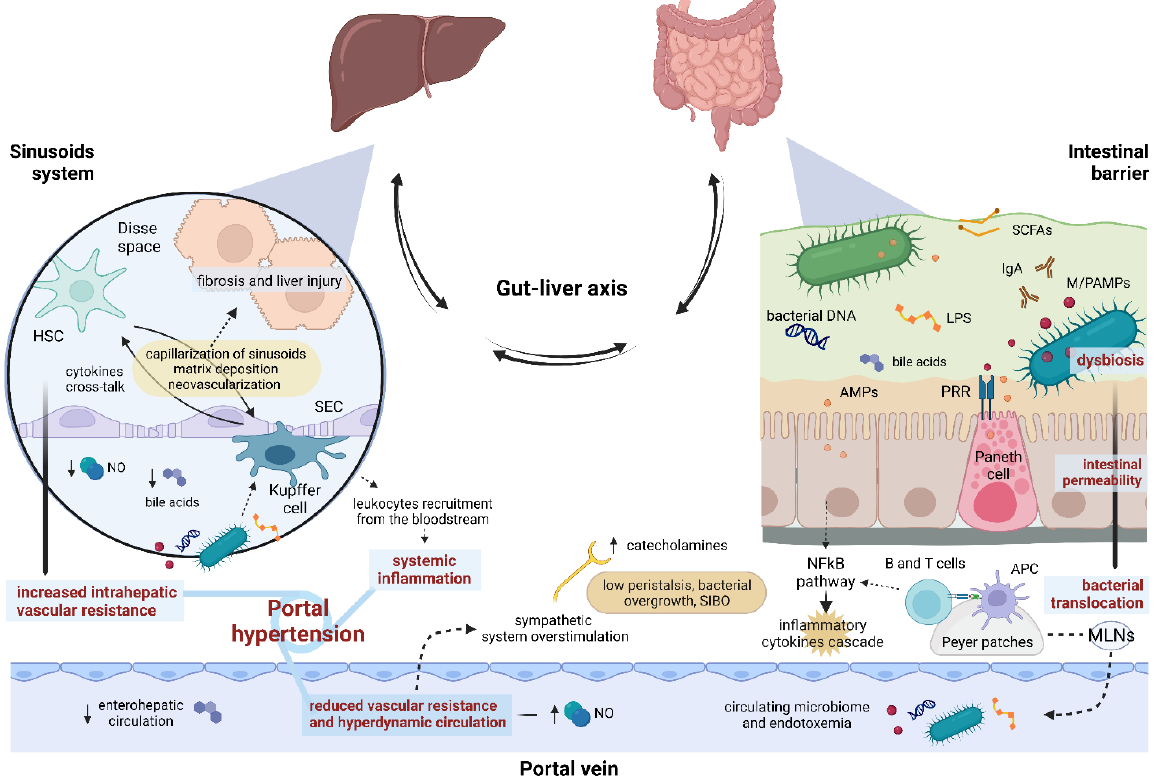
Figure 1. Gut–liver axis and portal hypertension. The intestinal barrier and the hepatic sinusoid system represent the two hinges of the firewall involved in containing bacterial translocation within the gut–liver axis. Impairment of continuous, bi-univocal communication between all these elements at several points gives rise to a vicious cycle leading to portal hypertension. AMPs, antimicrobial peptides; APC, antigen-presenting cell; HSC, hepatic stellate cell; LPS, lipopolysaccharide; M/PAMPs, microbiome/pathogen-associated molecular patterns; MLNs, mesenteric lymph nodes; NO, nitric oxide; PRR, pattern-recognition receptor; SCFAs, Short-chain fatty acids; SEC, sinusoidal endothelial cell; SIBO, small intestinal bacterial